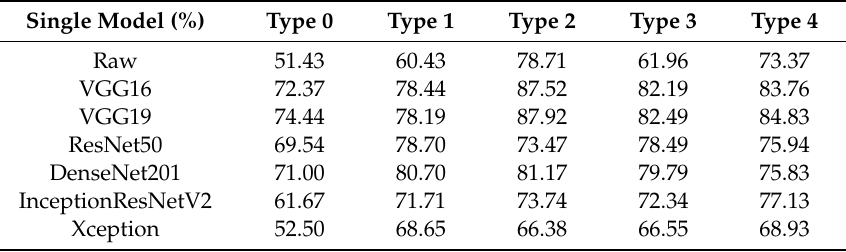
Table 10. Classification performance of the CNNs with data augmentation under transfer learning (4 classes).